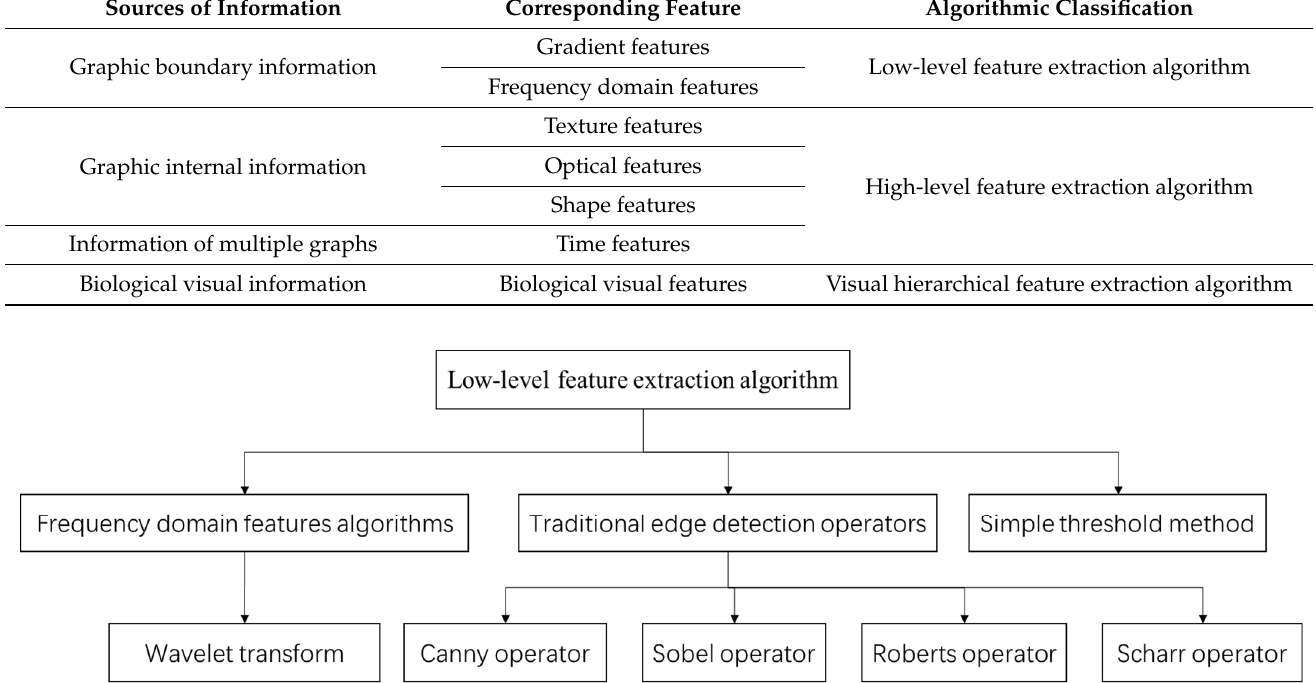
Figure 3. Classification of low-level feature extraction